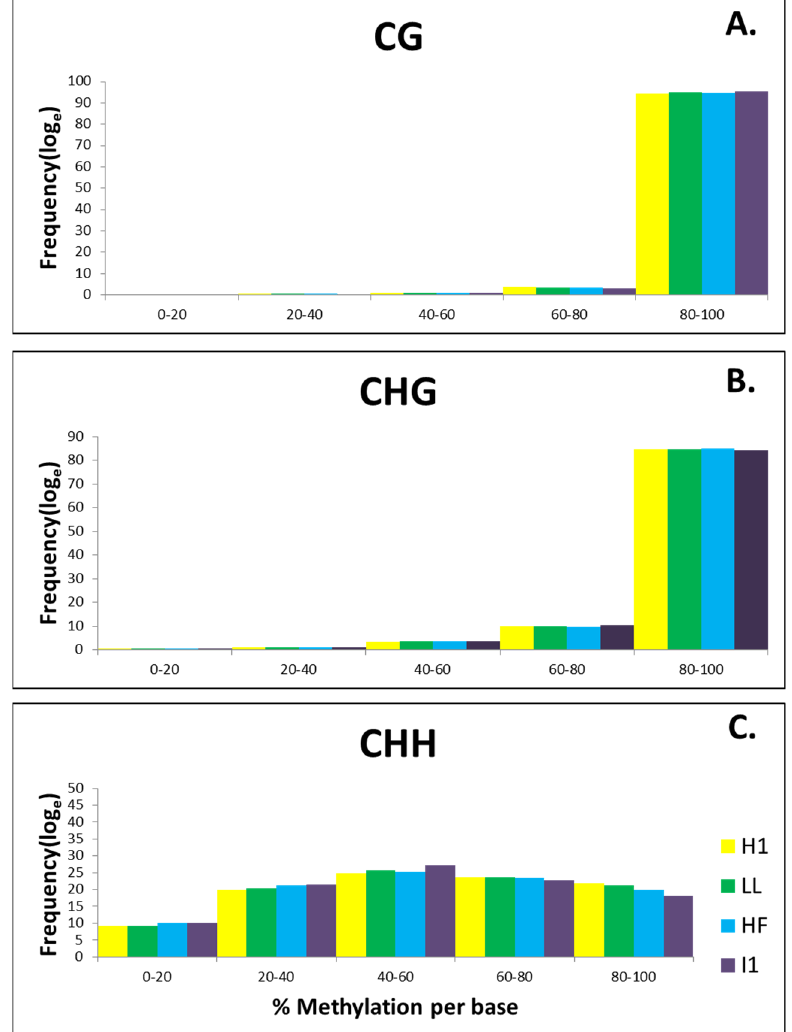
Figure 5. Distribution of ( A ) mCG ( B ) mCHG ( C ) mCHH level in healthy flowering (HF), phyllo- dy-affected (I1), healthy vegetative (H1) and little leaf-affected (LL) sesame samples. The x–y axis indicates bins of percent methylation per base and frequency of total Methylcytosines in each bin,